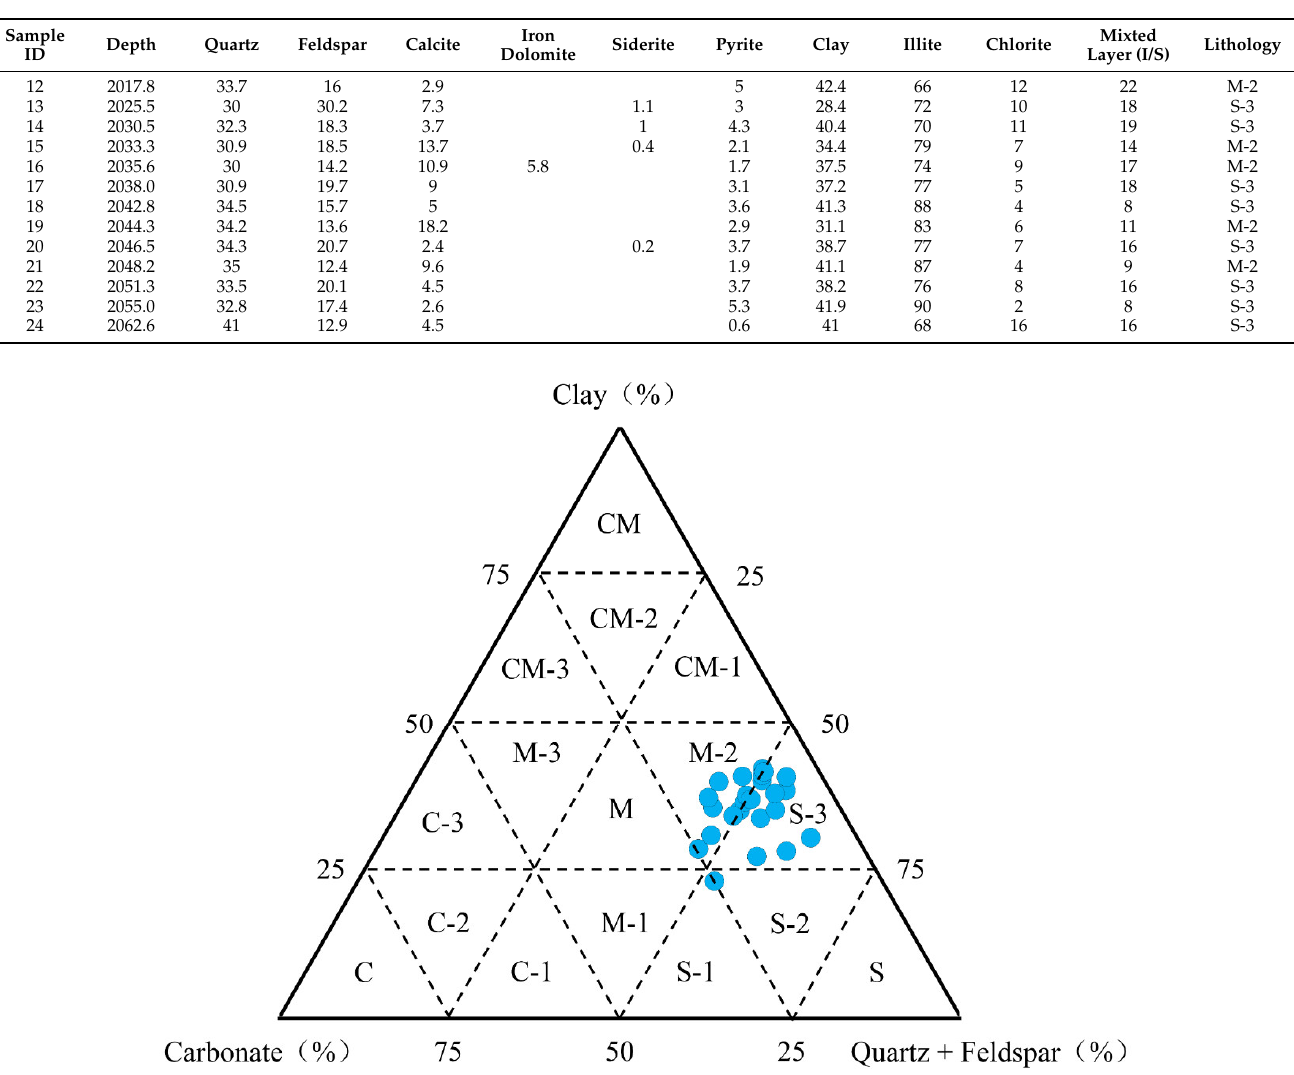
Figure 3. Classification of shale lithofacies in the study area (Adapted from Refs. [19–21]). S: Siliceous